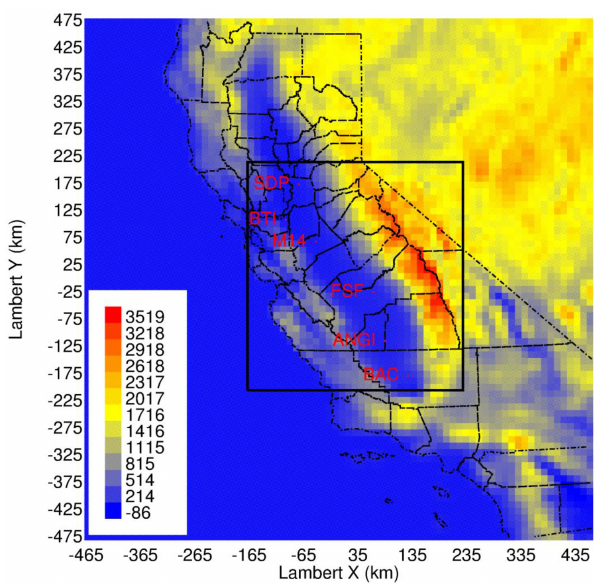
Fig. 1. Relative configuration of the nested WRF computation do- mains together with locations of 6 observation sites. The 4km do- main illustrated by the rectangle box covers the Central Valley. Color shows the terrain elevation in unit of